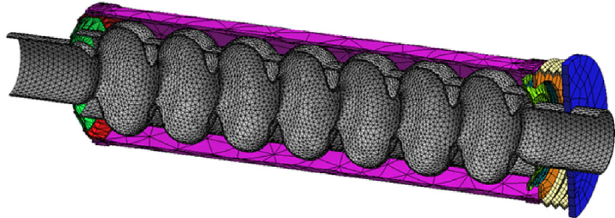
FIG. 5. ANSYS mesh of the ERL 7-cell cavity with helium tank. The tan bellows-like part on the right is the simplified tuner. It is supported by the rigid blue plate. In this model, the stiffening rings between the cells have a 155 mm inner diameter.